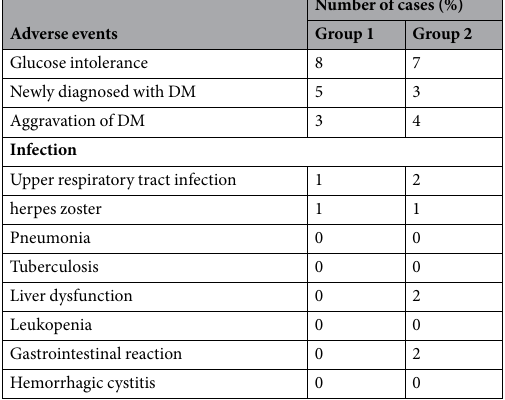
Table 5. Adverse events observed during treatment in patients with